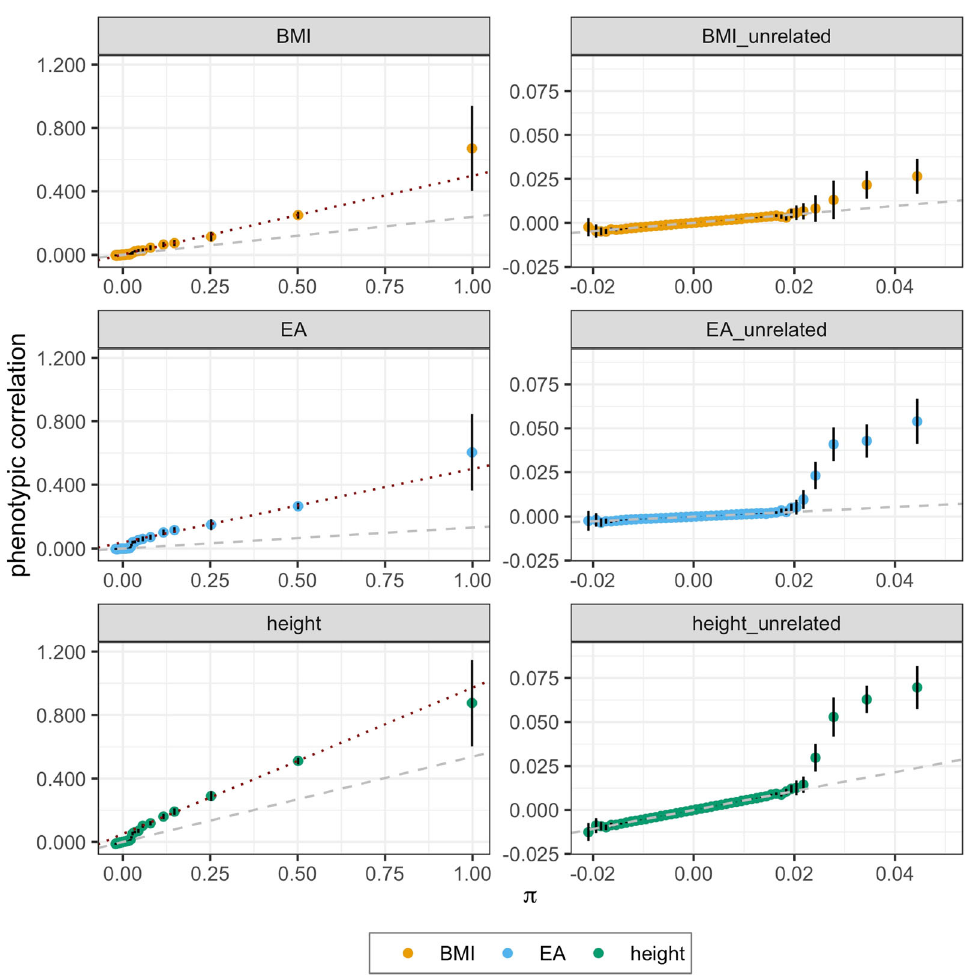
Fig. 2 Phenotypic correlation between pairs as a function of genomic relationship ( π ). Traits shown are body mass index (BMI), educational attainment (EA) and height; with either all pairs (left) or highlighting the regression of phenotypic covariance on genomic relationship in un- and distantly related ( π < 0 : 05) pairs (right). Points indicate the mean correlation from all data, with vertical bars showing 95% con fi dence intervals ( ± 1 : 96s : e : , where standard errors are derived from a blocked jacknife procedure with 100 blocks of individuals). Dashed grey line shows the best fi t line for unrelated individuals (interpreted as the SNP-heritability, ^ h 2 SNP ) and the red dotted line shows the fi t line for close relatives (interpreted as ^ h 2 π > 0 : 05